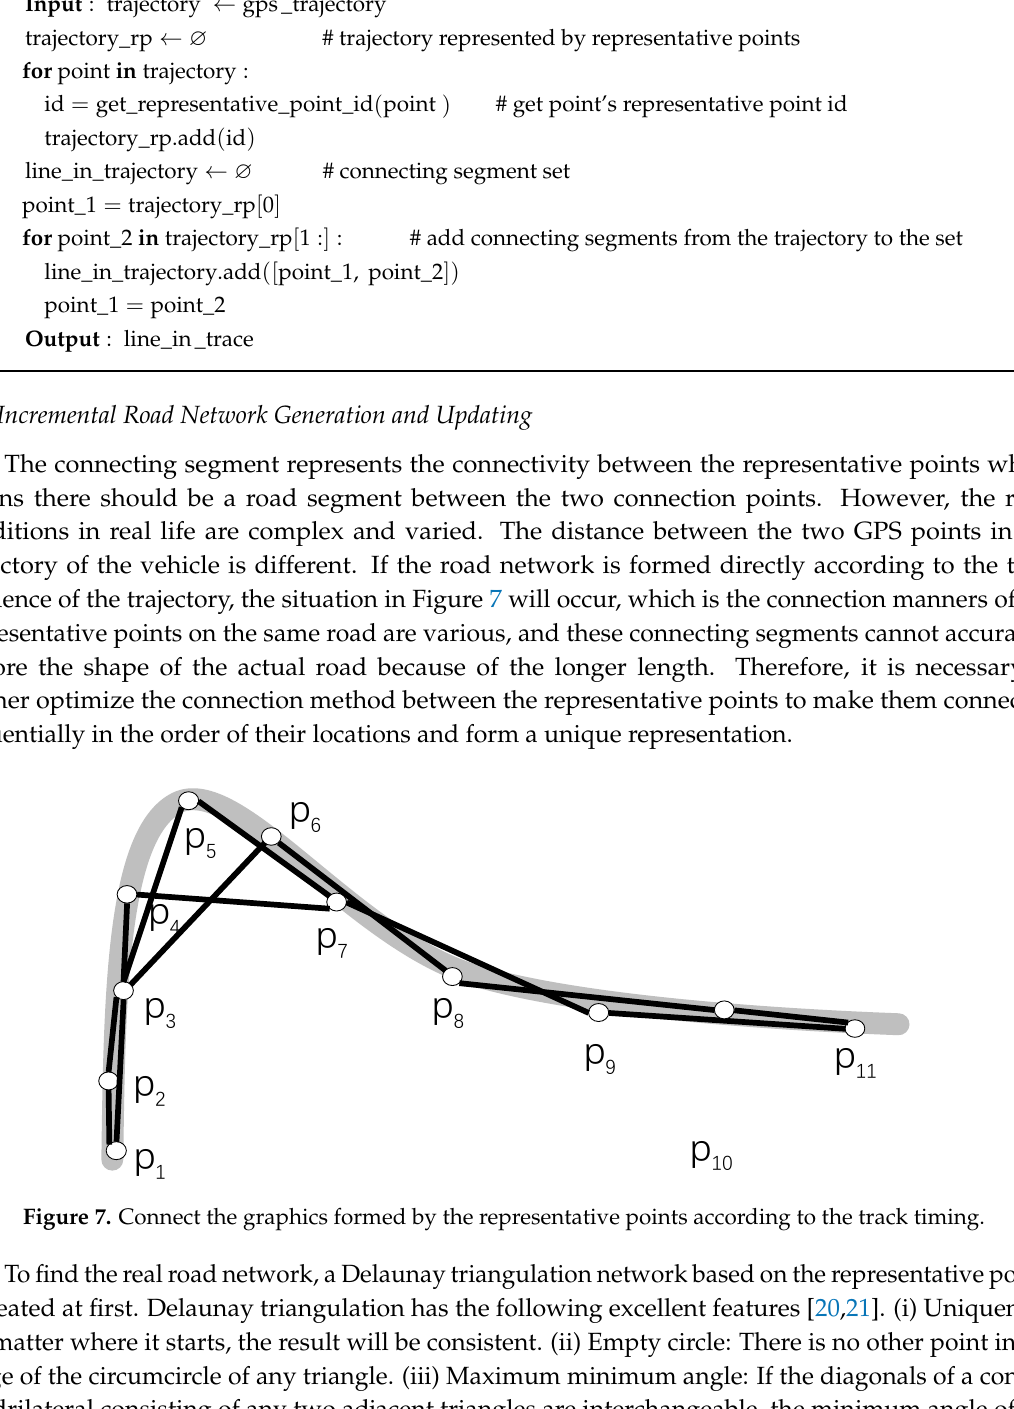
quadrilateral consisting of any two adjacent triangles are interchangeable, the minimum angle of the six internal angles will no longer increase after interchanging. Based on these three characters and the nature of real road network, almost all physically adjacent representative points along a road will be connected by edges of its Delaunay triangulation network as depicted in Figure